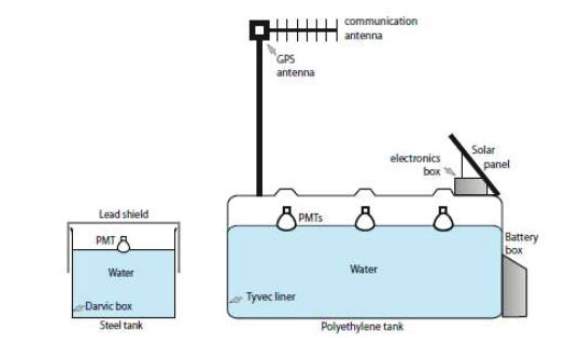
Fig. 1. Scale comparison of Porter’s water -Cherenkov detectors with a detector at the Auger Observatory [from 31]. The array at Harwell was also used to explore the showers traverse the atmosphere. This arose directly from a study by Blackett [32] of the essential features of Cherenkov radiation in